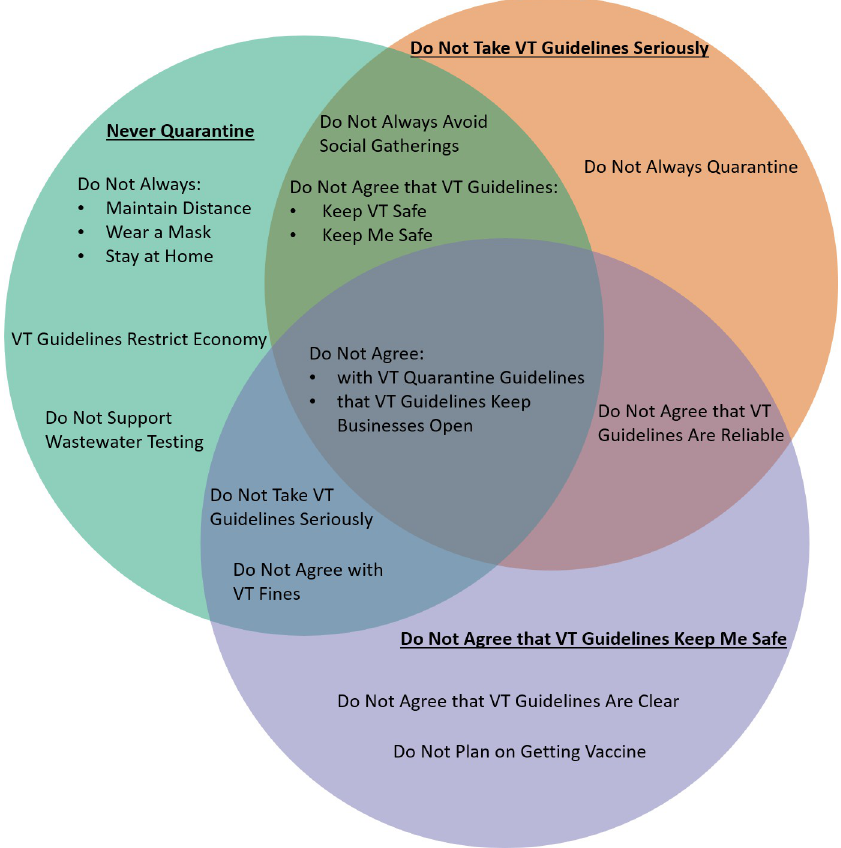
Fig 3. Factors associated with respondents who responded negatively to Vermont’s COVID-19 guidelines, January–April